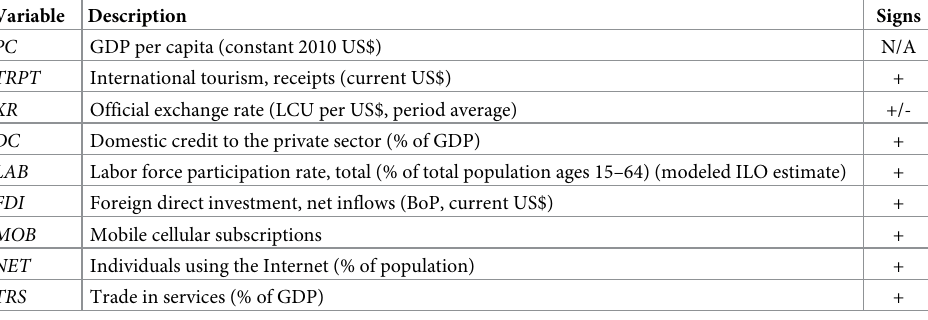
Table 1. Variables description, and